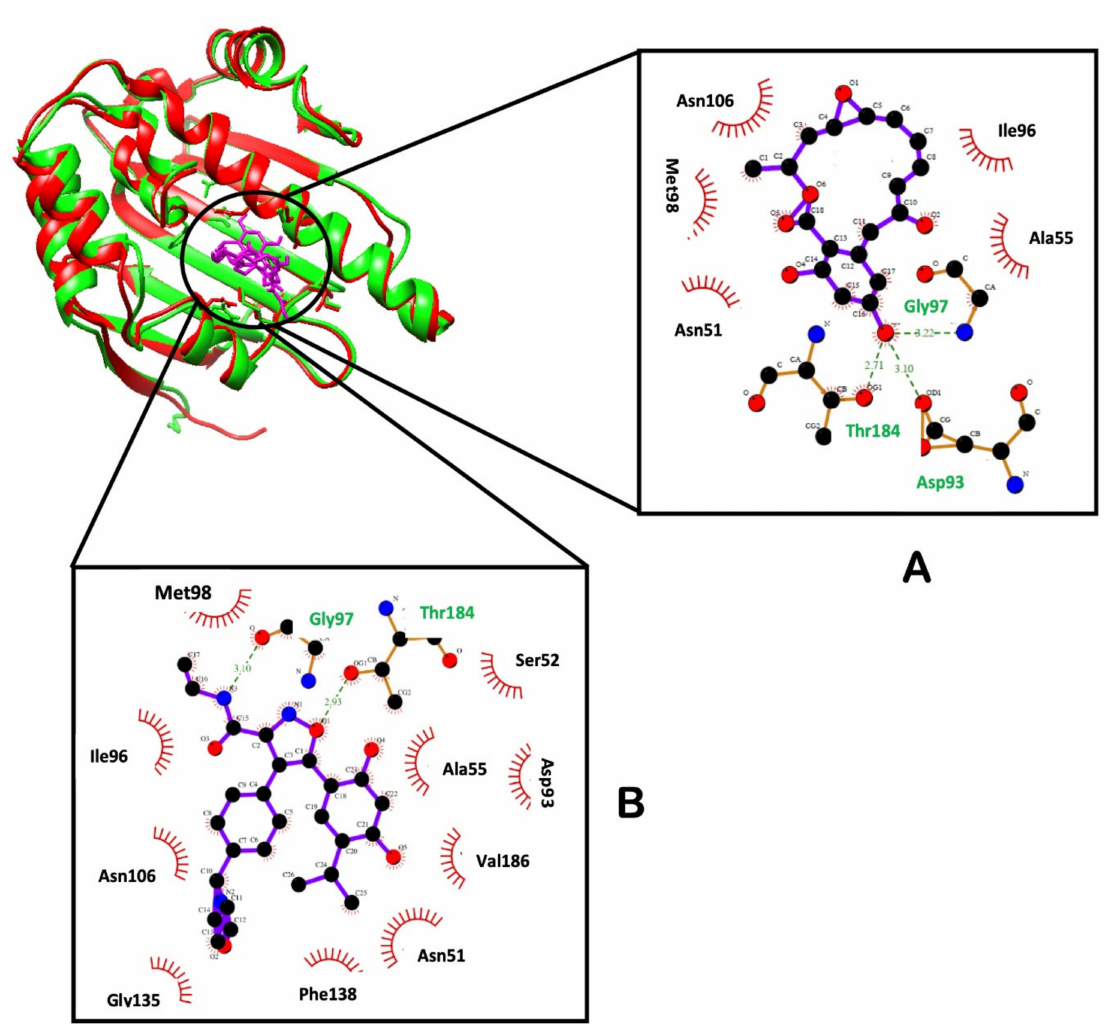
Figure 11. The interactions of ( A ) RD and ( B ) NVP with Hsp90 residues within the ATP-binding pocket (plotted by